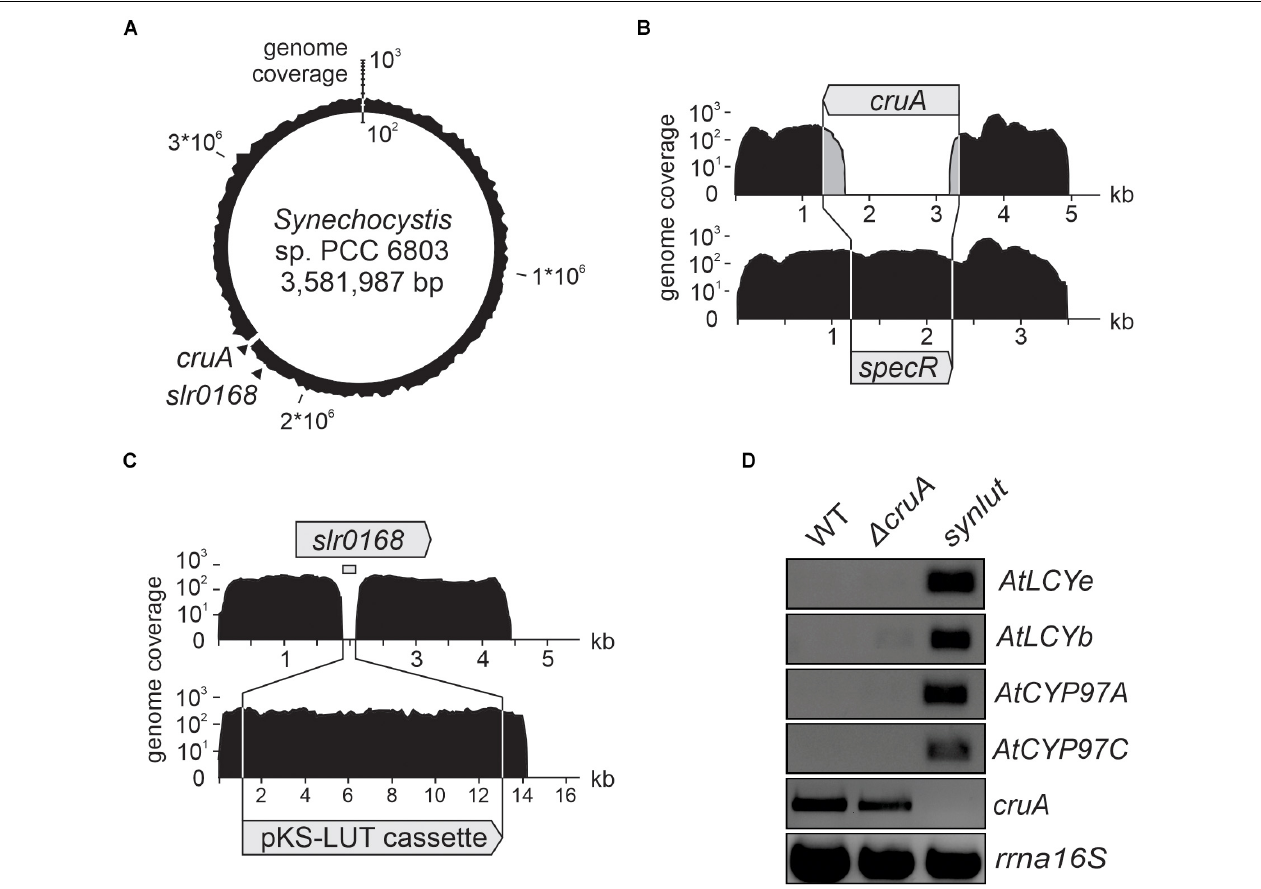
FIGURE 5 | Whole-genome resequencing and expression analysis of synlut . (A–C) Schematic depiction of the density of coverage of the (A) synlut chromosome, (B) of the cruA locus in synlut and (C) of the pKS-LUT cassette in the neutral integration site slr0168 . Sequence reads assembled in (B) and (C) were either mapped to the wild type (WT, upper panel) or the synlut reference genome (lower panel). Genome coverage values in (A–C) are shown on a logarithmic scale. Gray shading in (B) indicates false alignments of sequence read ends. Absolute values are listed in Table 1 . (D) Reverse transcription-PCR analyses of RNA samples isolated from WT, (cid:49) cruA and synlut strains. AtLCYe , AtLCYb , AtCYP97A , AtCYP97C and rrnA16S cDNAs were amplified over 25 cycles, and the cruA cDNA was subjected to 30 PCR cycles, respectively. A PCR-based segregation analysis of synlut is provided in the Supplementary Figure 1 . Full-length gels of panel (D) are presented in the Supplementary Figure 2C